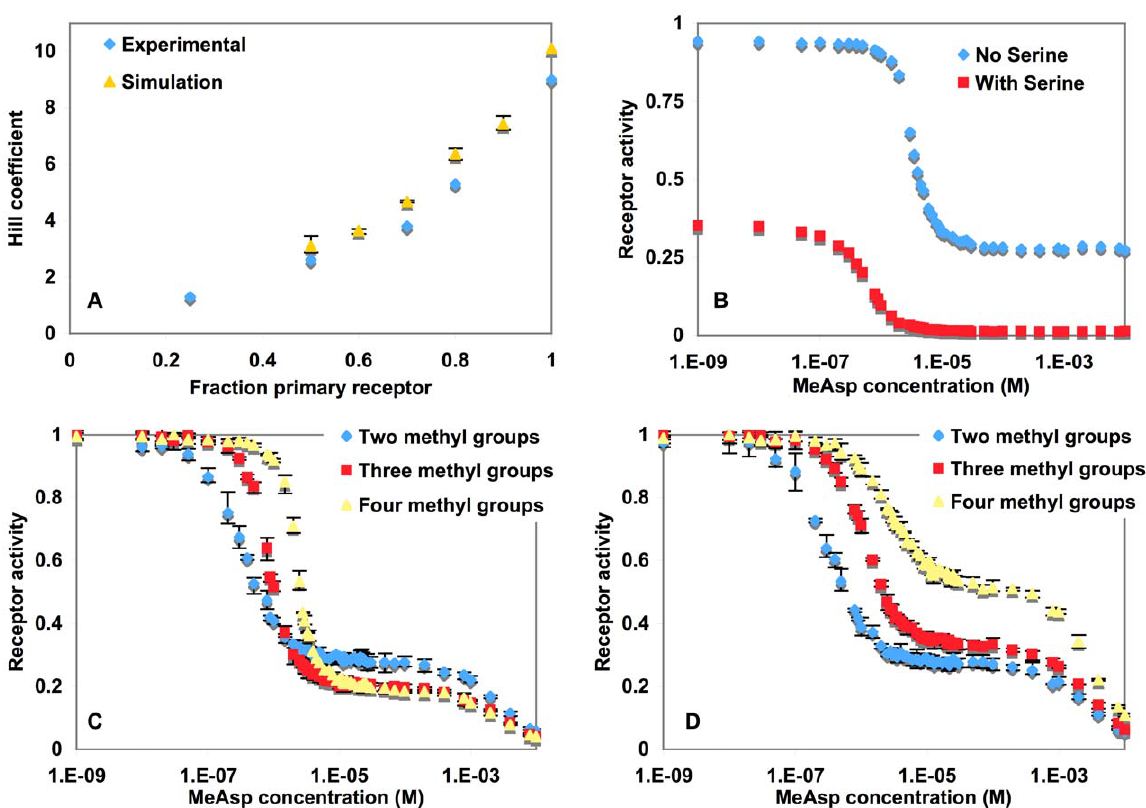
Figure 4. Receptor simulations, each data point derived from the average value of triplicate runs. ( A ) Hill coefficients for the activity of a primary receptor bound by its ligand, as the ratio of primary to secondary receptor was varied, with experimental data from [17]. ( B ) Fractional total receptor activity (Tar + Tsr) as a function of MeAsp concentration, in the absence ( ¤ ) or presence ( & ) of Ser attractant ligand, which deactivates the Tsr receptors. In the presence of Ser, the baseline activity of the receptors is suppressed to , 30%, corresponding to the inactivation of the Tsr receptors, and the sensitivity to MeAsp, defined as the ligand concentration at which the activity of the system is one half relative to baseline (K 1/2 ), increased , 6 fold, from 3.3 6 10 2 6 M to 5.6 6 10 2 7 M. The Tar receptors have a diminished ability to inhibit the overall activity of the receptor patch, even though they initially account for a larger portion of the overall activity, in agreement with experimental results from [16]. ( C and D ) Plots of combined Tar and Tsr receptor activity versus MeAsp concentration for methylation independent receptor coupling ( C ) and methylation dependent receptor coupling ( D ). In ( C ), as the methylation level increases, there was a greater relative response from Tar binding to MeAsp, contrary to the experimental data from Sourjik and Berg [16], and ( D ) brings the simulation data in line with the experimental data by introducing the term % , which affects receptor cooperativity based on methylation level. ( ¤ : Tar Methylation 2, & : Tar Methylation 3, m : Tar Methylation 4). Tsr was fixed at methylation level 2 in all